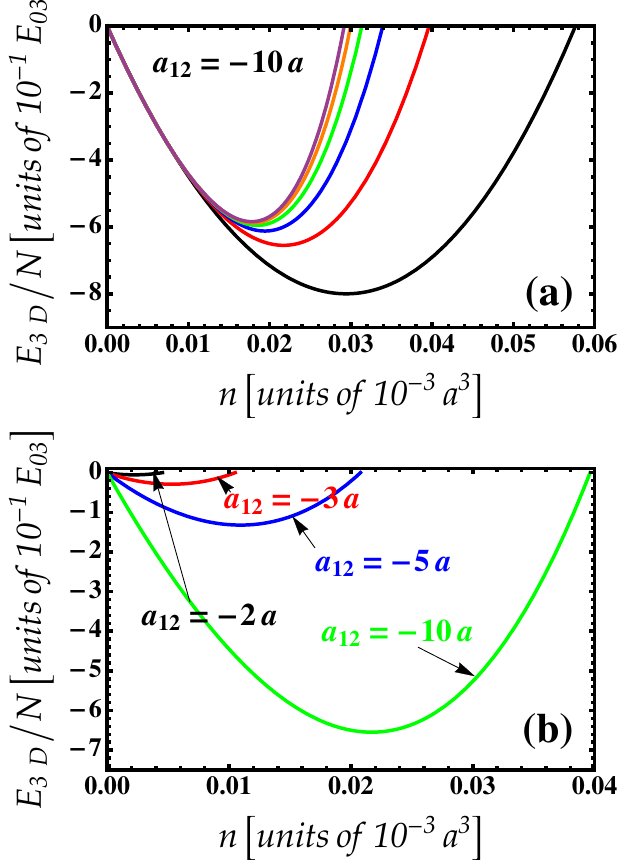
Figure 2. (Color online) ( a ) Three-dimensional ground-state energy from Equation (8) as a function of the density for a 12 / a = − 10. Black line: zeroth-order corrections. Red line: first-order corrections. Blue line: second-order corrections. Green line: third-order corrections. Orange line: fourth-order corrections. Purple line: fifth-order corrections. ( b ) Three-dimensional ground-state energy up to second-order corrections as a function of the density for different values of